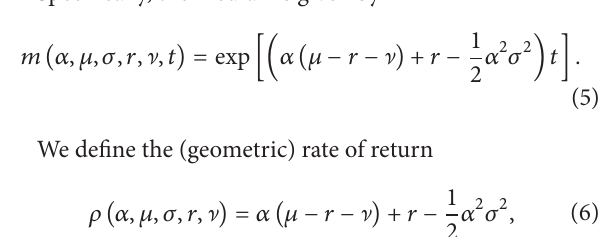
also assume that 𝛼 = 50 % is invested in stocks and that ] = 0 , so there are no administrative